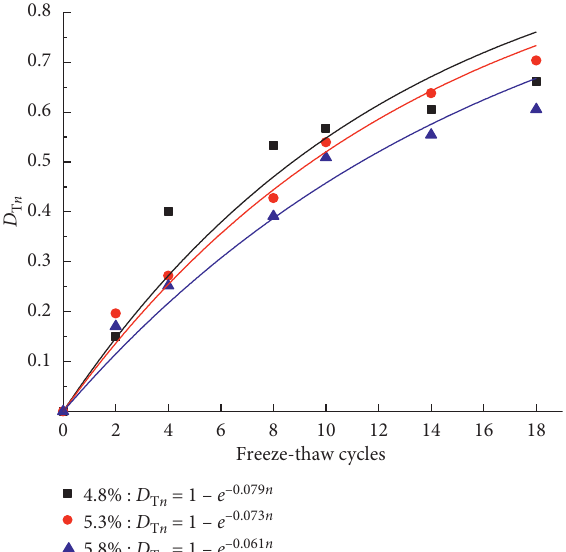
Figure 5: Fitting curves of the split degree of freeze-thaw damage vs. freeze-thaw cycle of S-grade mixtures. Table 5: Correlation coefficients R